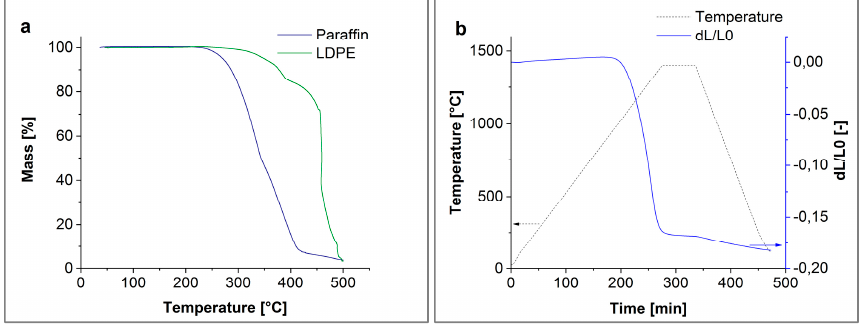
Figure 4. ( a ) Thermographimetric analysis (TGA) of paraffin and LDPE, and ( b ) TGA of dilatometer Al 2 O 3 .